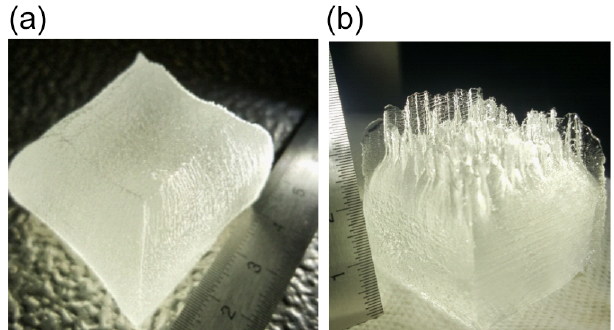
Figure 5. Ice after 4cm of sublimation. Penitentes in panel (b) oc- cur at pressures of more than 0.15–0.2hPa measured at the top of the extraction vessel, while in panel (a) the pressure was kept below